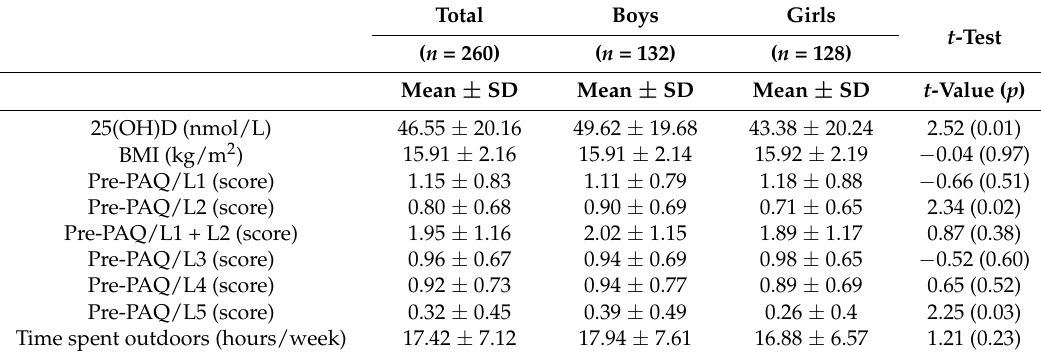
Table 1. Descriptive statistics for the observed variables with differences between genders ( t -test for independent samples).